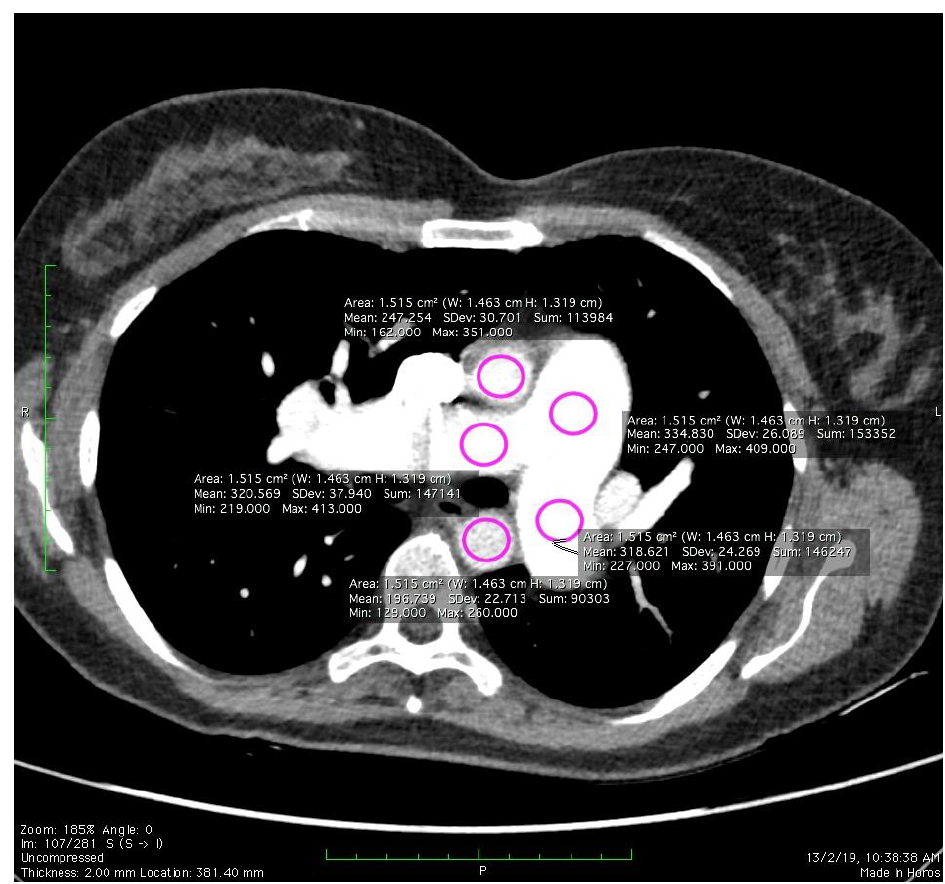
Figure 2. Placement of the regions of interest (ROI) for the noise magnitude calculation.